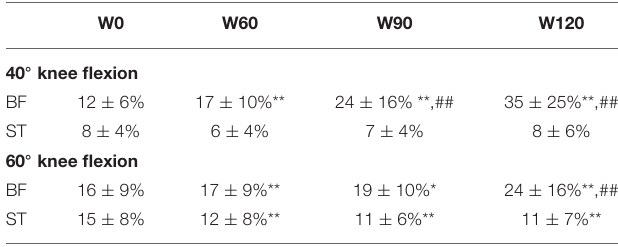
orientation of the ski resulted in the medial movement of the knee joint.